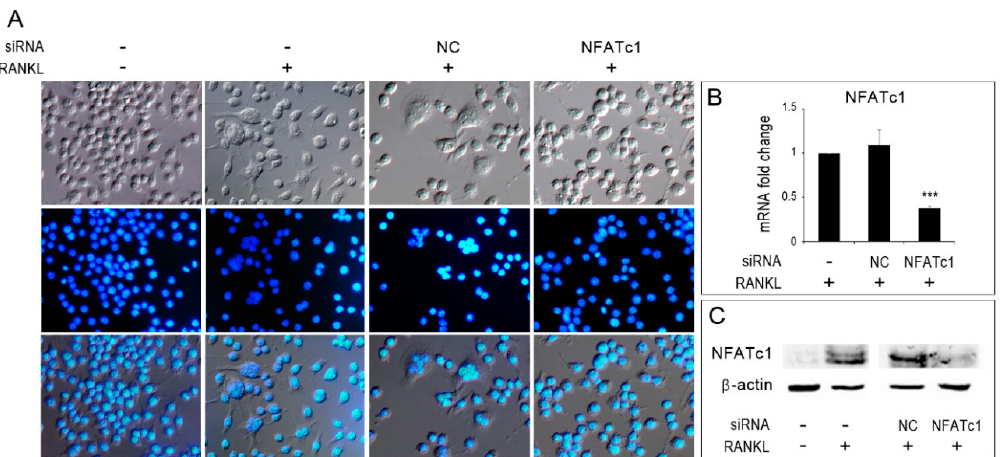
Figure 1. Inhibition of osteoclastogenesis by silencing of NFATc1. Untransfected, siRNA-non correlated (NC) and siRNA-NFATc1 transfected cells were cultured with RANKL (50 ng/mL) for 24 h. Control untransfected cells were cultured without RANKL. ( A ) Cells were fixed, stained with DAPI (which stains the nuclei blue) and observed by DIC (upper row) and immunofluorescence (middle row) microscopy. Bottom row shows merged images. ( B ) Quantitative PCR (QPCR) of NFATc1 . mRNA expression was presented as relative values to those expressed in untransfected cells ( − /+RANKL) arbitrarily set at 1.0. The results shown are the means ± SD of two experiments (each of which was performed in triplicate). *** p < 0.005. ( C ) Western blot of NFATc1 protein in untransfected ( − / − RANKL) and ( − /+ RANKL), siRNA-NC and siRNA-NFATc1 transfected cells (+RANKL). The data shown represent two independent experiments with comparable